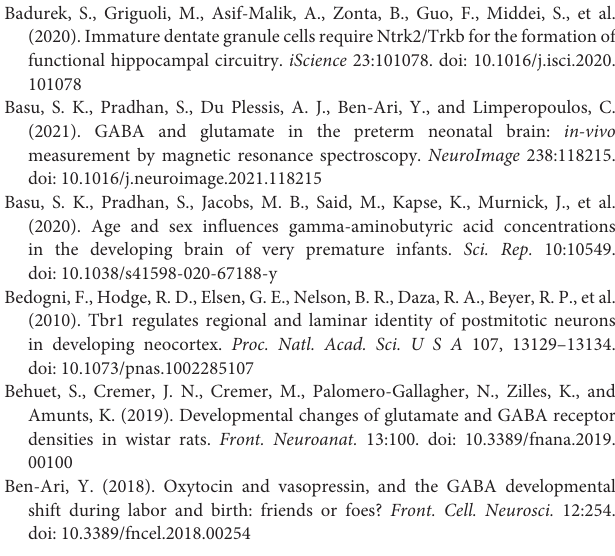
SUPPLEMENTARY FIGURE 1 | Quantification of (A) DAPI positive cells in sum of the DG of control animals (100% white bars), DMCM hydrochloride (DMCM) in doses of either 2 µ g/kg, 10 µ g/kg or 50 µ g/kg, and CGP 35348 in doses of either 0.4 mg/kg, 2 mg/kg or 10 mg/kg treated rat pups at P11. Data are expressed relative to the control group as mean ± SEM of n = 10 each group. The 100% values are 594.1 cell counts (Brown-Forsythe test). Expressions of (B) AIF and Casp3 are not affected by the application of DMCM or CGP. The relative mRNA expressions of markers were measured by quantitative real-time PCR in rat brain homogenates with DMCM 50 µ g/kg (gray bars) or CGP 10 mg/kg (black bars) application relative to control (white bars). Bars represent the relative mRNA quantification based on internal standard HPRT . Data shown as mean ± SEM, n = 9–10 (one-way ANOVA). SUPPLEMENTARY FIGURE 2 | Representative hippocampal paraffin sections (A) of control animals, DMCM hydrochloride (DMCM) in dose of 50 µ g/kg and CGP 35348 in dose of 10 mg/kg treated rat pups at P15 co-labeled with DAPI and NeuN. Application of GABA receptor antagonists did not affect cell counts for postmitotic NeuN+ neurons at the DG. Quantification of (B) NeuN positive cells in sum of the DG in comparison to control group (100% white bars). Data are expressed relative to the control group as mean ± SEM of n = 10 each group. The 100% values are for NeuN+ 187.3 cell counts (one-way